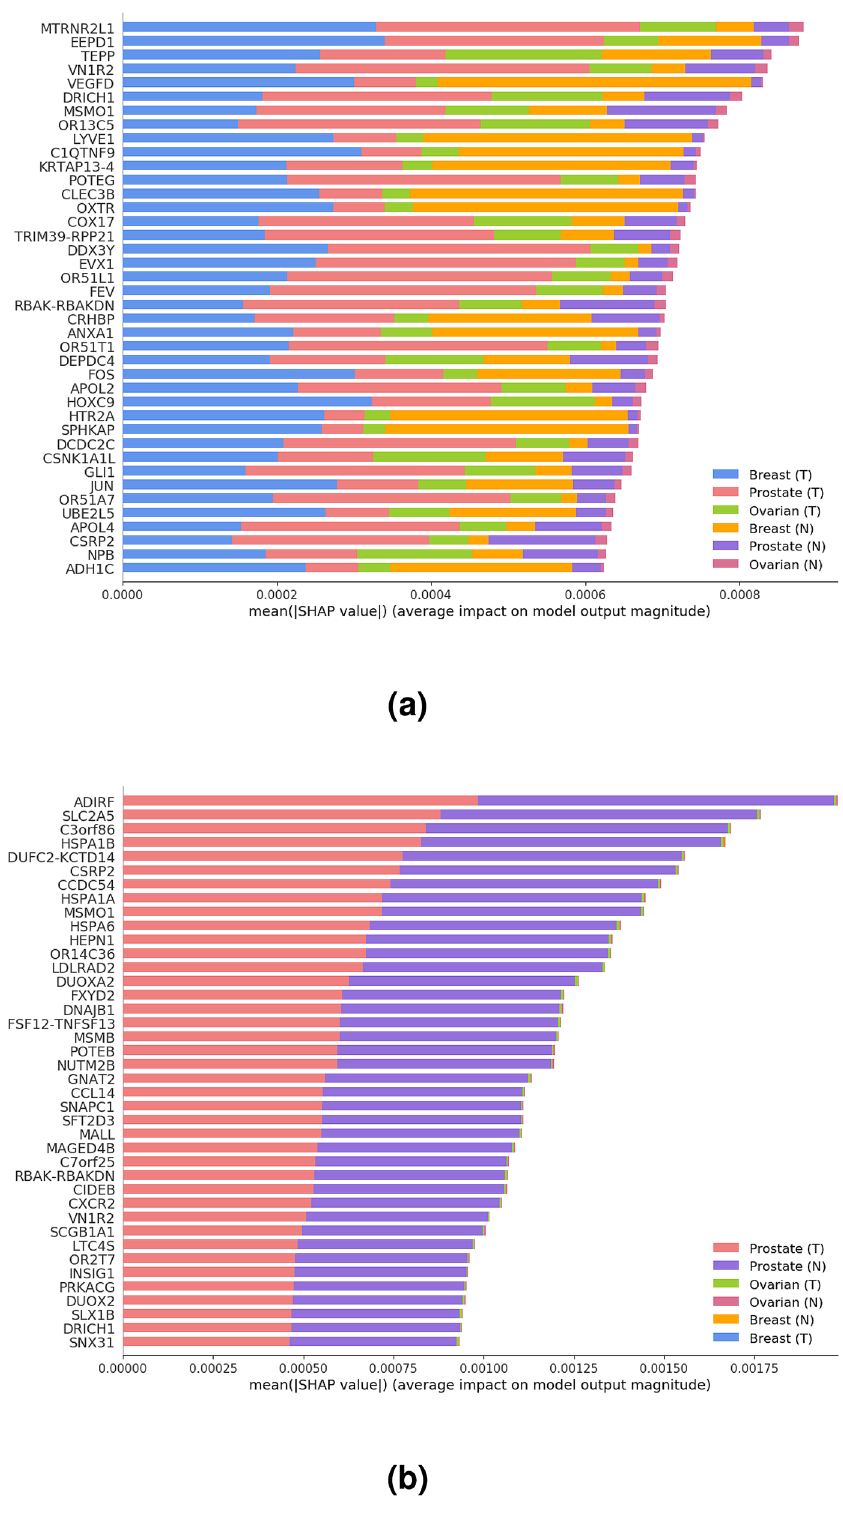
Figure 4. The most relevant genes identified by SHAP ordered based on ( a ) the total contribution scores of the three tissues and disease states (Top CC ALL), where (T) denotes tumor and (N) denotes normal, and ( b ) contribution scores identified solely based on the prostate tissue and its disease state (Top CC PR). Note that the gene-specific contribution scores (x-axis) are not directly comparable across ( a ) and ( b ), as each gene’s score is based on a normalized calculation where the total contribution score across all genes ( ≈ 19 K) sums up to